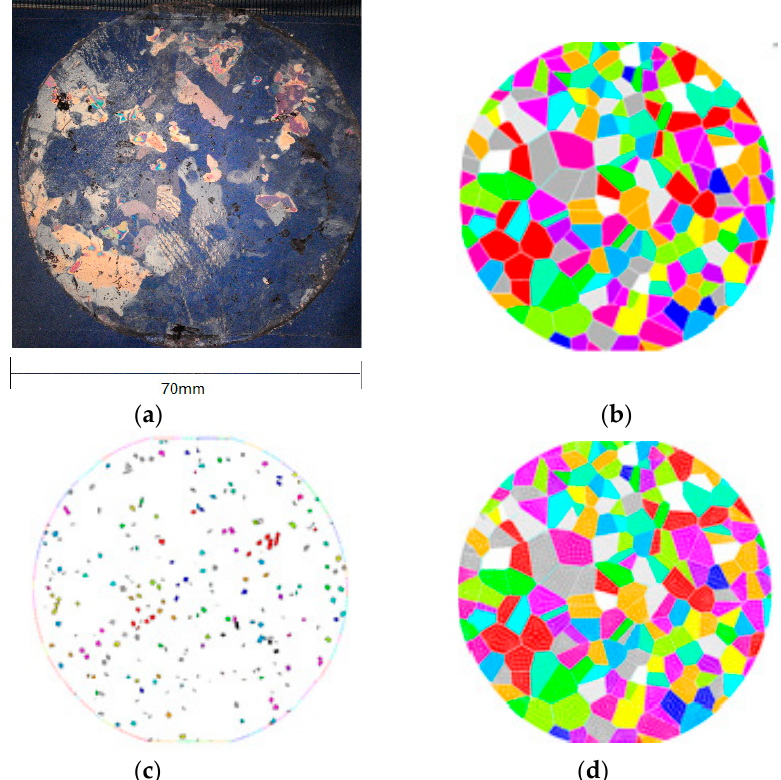
Figure 2. Finite element model of the river ice crystal structure: ( a ) typical sample diagram of the ice crystal structure of Yellow River; ( b ) structure diagram of the numerical model of the Brazil disk specimen; ( c ) initial defects inside the disk; and ( d ) sketch map of the whole model.